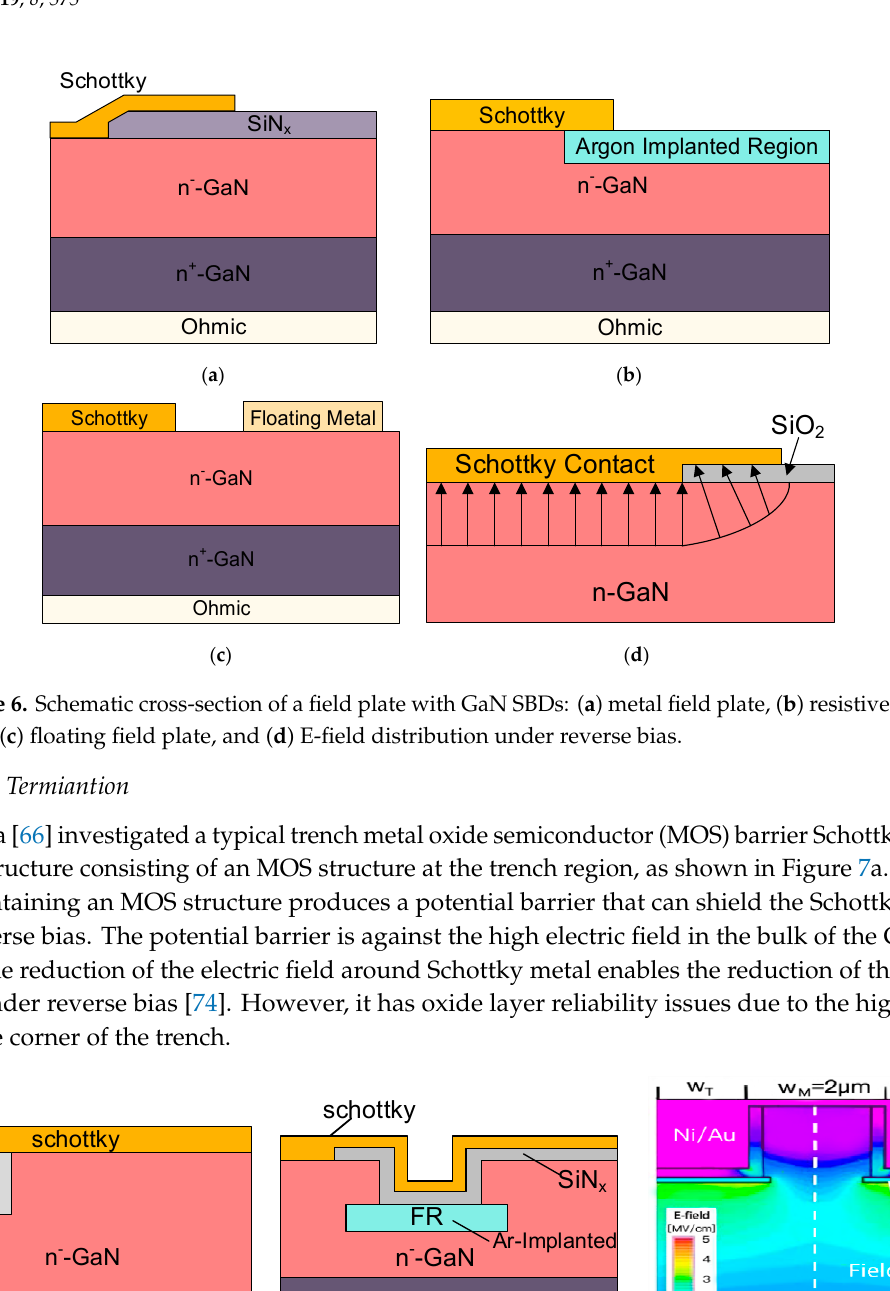
( b ) Figure 8. ( a ) Schematic cross-sections of GaN reduced surface field (RESURF) junction barrier- controlled Schottky (JBS) structure and ( b ) comparison of simulated E-field distribution of typical SBD with RESURF JBS at − 200 V. 3.6. N-Based Termination N-based termination (NT) techniques was reported by Yang et al. [6,81], as shown in Figure 9. By utilizing the nitridation plasma to form an N-based termination region around the edge of the anode, the N vacancies can be compensated and the Ga dangling bonds on the GaN surface can also be passivated. The NT structure at the junction edge presents a higher energy barrier height and/or effective barrier thickness around vertical GaN SBDs. Therefore, the leakage current at the edge is decreased under reverse bias due to the suppression of electron transport via thermionic-field emission (TFE) or tunneling. The NT-SBD with a BV of 995 V and a R ON,sp of 1.2 m Ω ·cm 2 has shown excellent static (high J F density of 2000 A/cm 2 ) and switching characteristics (fast reverse recovery